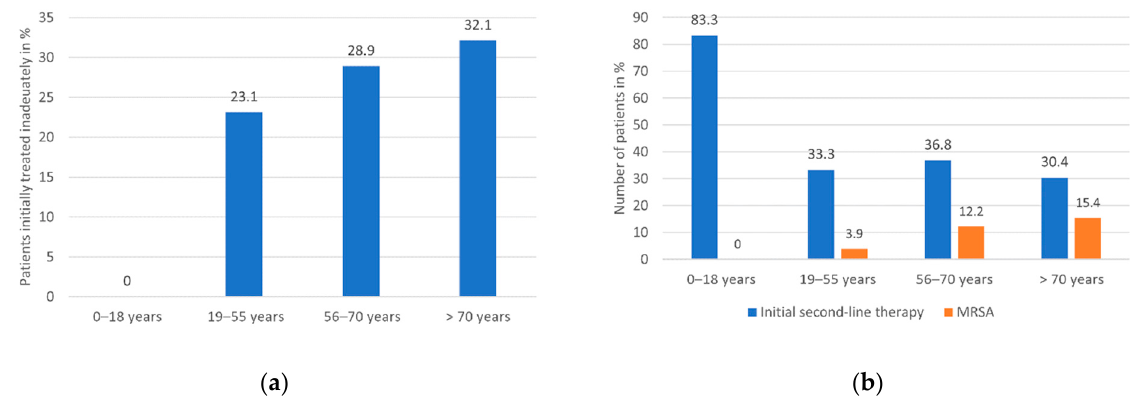
Figure 8. ( a ) Numbers of patients who received inadequate initial therapy per age group in percent. Inadequate initial treatment was associated with advanced age, whereby patients in the age groups 56–70 years and older than 70 years were significantly more likely to receive inadequate initial therapy than patients aged 0–18 years ( p = 0.035 and p = 0.022, respectively; missing data of 33 patients). ( b ) Numbers of patients who initially received second-line therapy or were infected by MRSA in percent. Patients of the age group 0–18 years were likelier to receive second-line antibiotics as initial